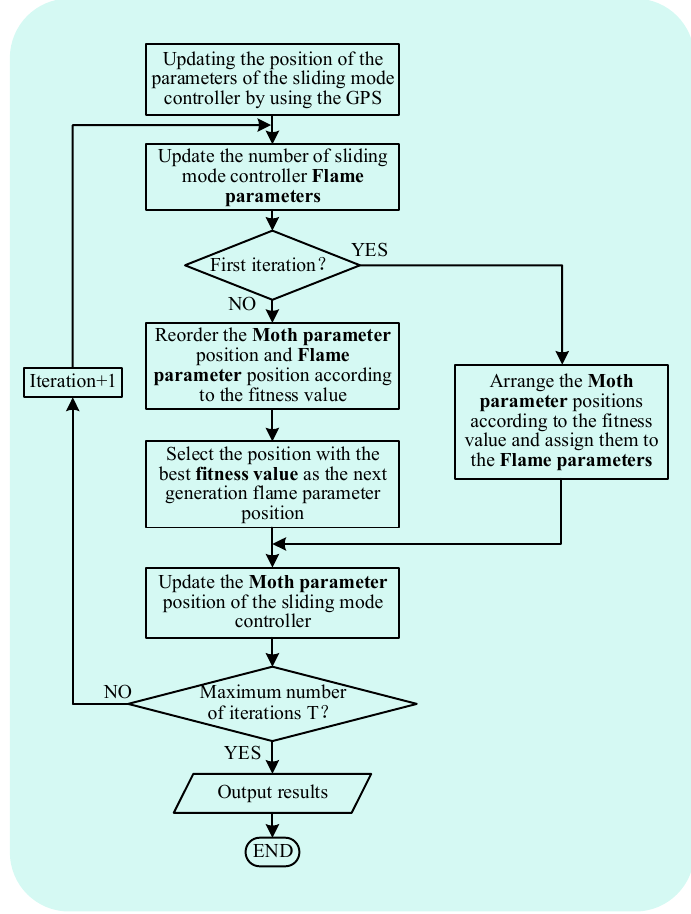
Figure 6. IMFO optimization flow chart.